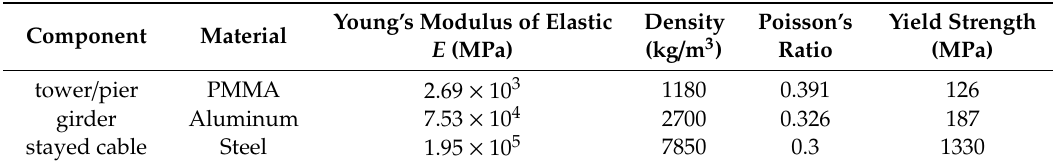
Table 3. Material properties of test model.